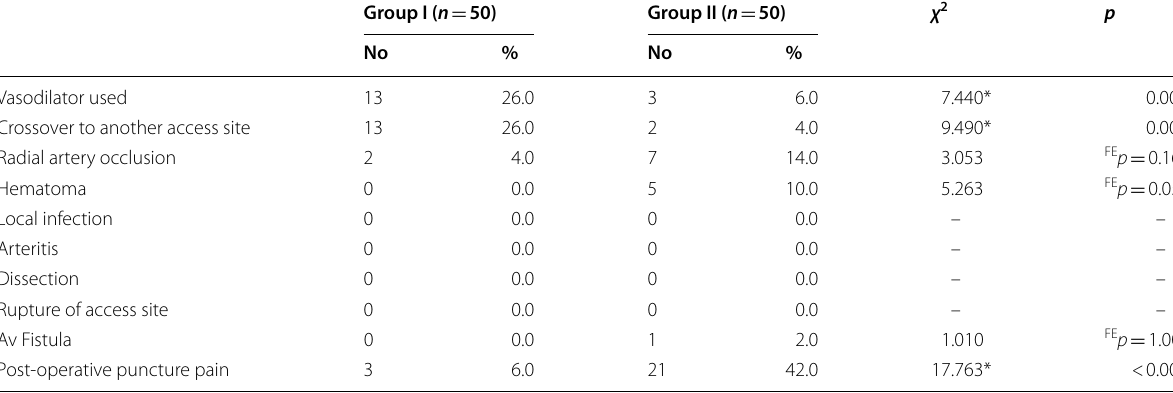
χ 2 Chi square test, FE Fisher exact, p p value for comparing between the studied groups, Group I distal radial artery, Group II conventional radial artery